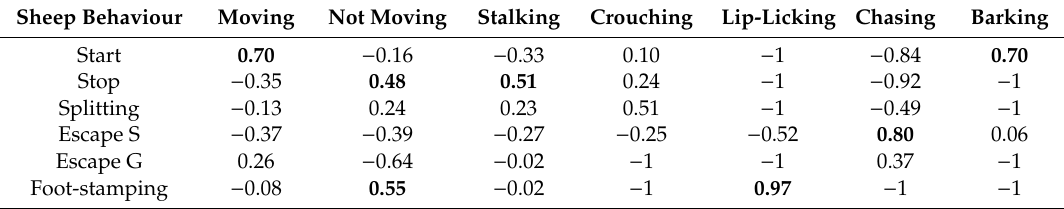
Table A7. Yule’s Q for Event-based sheep-initiated sequential behaviour paired interactions. Sheep Behaviour